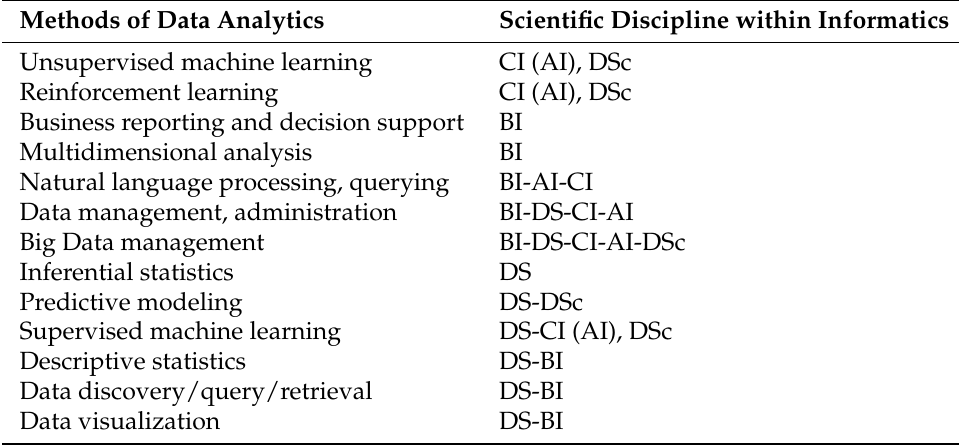
Table 2. Relationships between methods of data analytics and disciplines of informatics